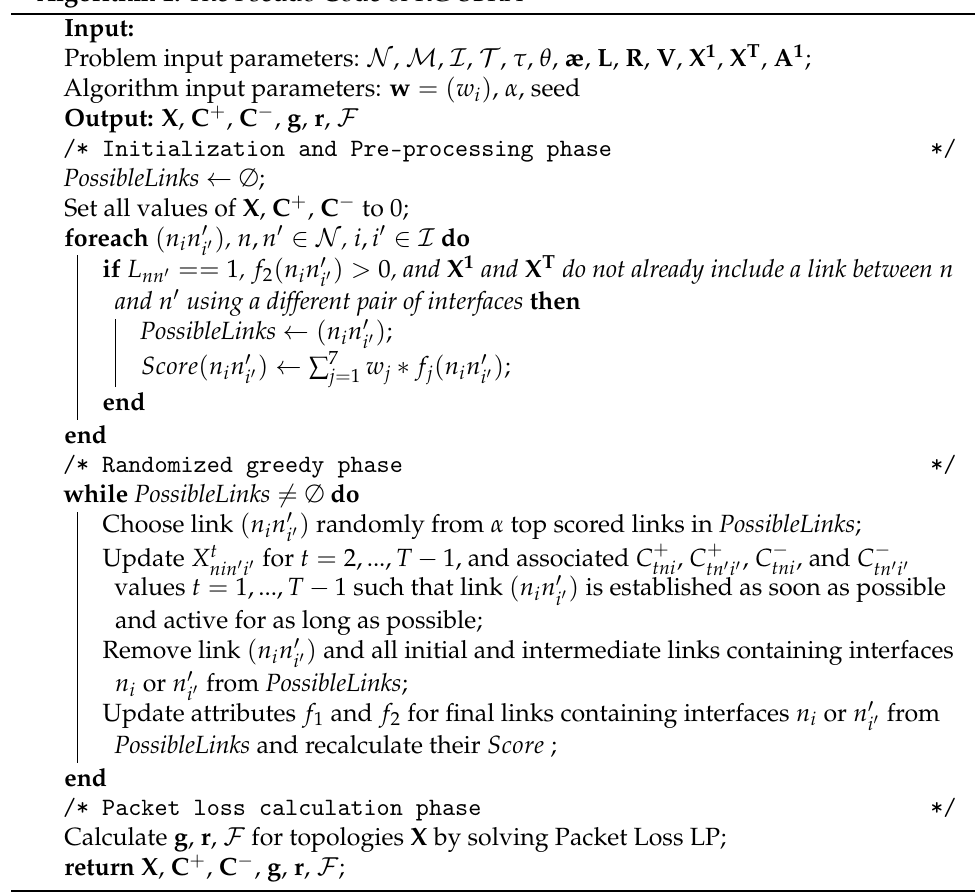
Algorithm 1: The Pseudo Code of